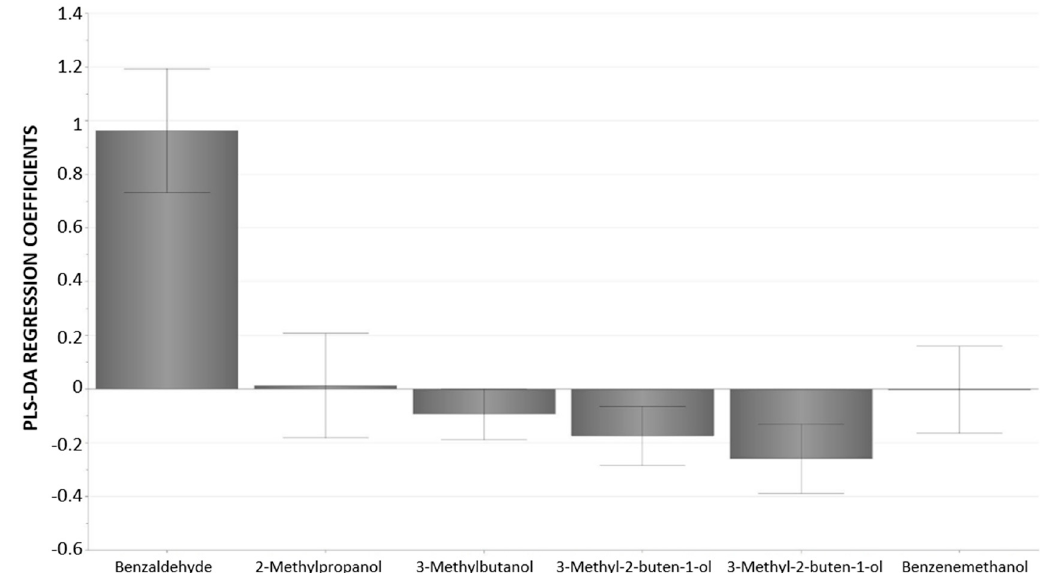
Figure 3. Partial Least Square-Discriminant Analysis (PLS-DA) regression coefficients for the heterozygous ( Sksk ) category, with confidence intervals derived from jack-knifing.